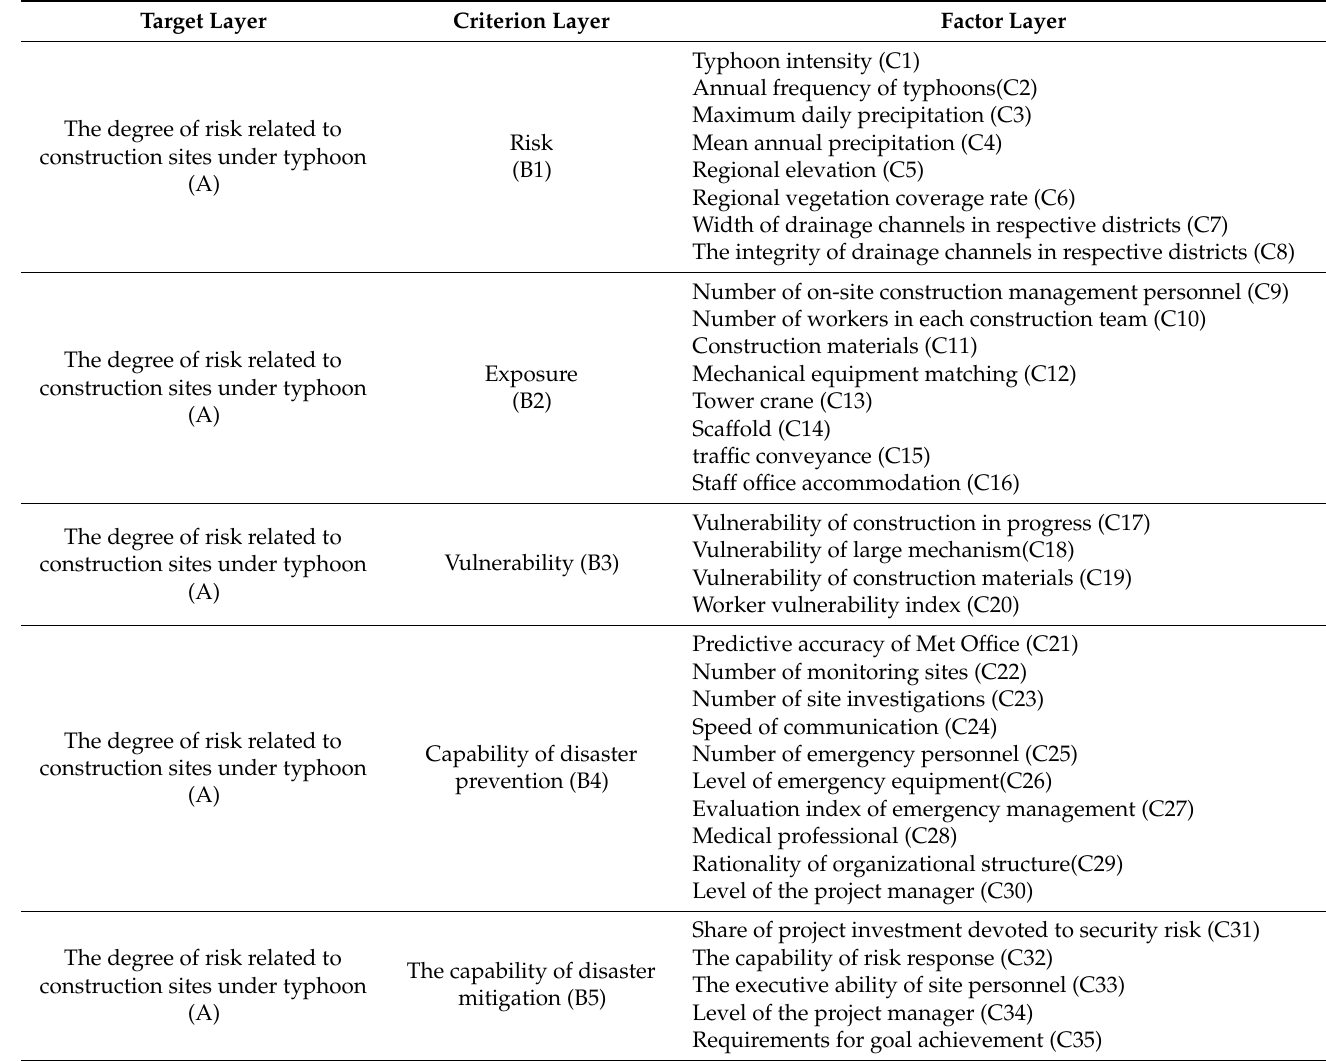
Table 1. Risk index decomposition for construction sites under